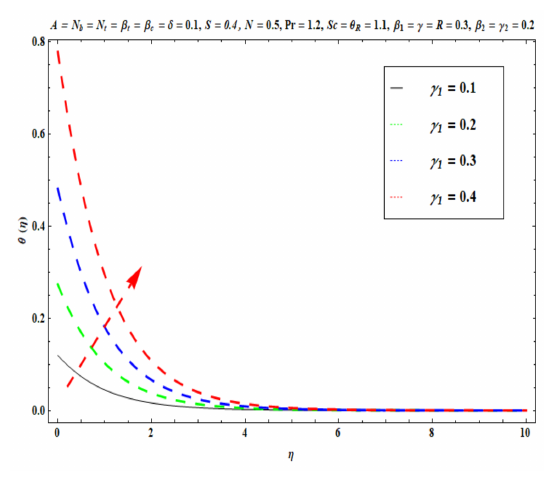
Figure 14. Against γ 1 .